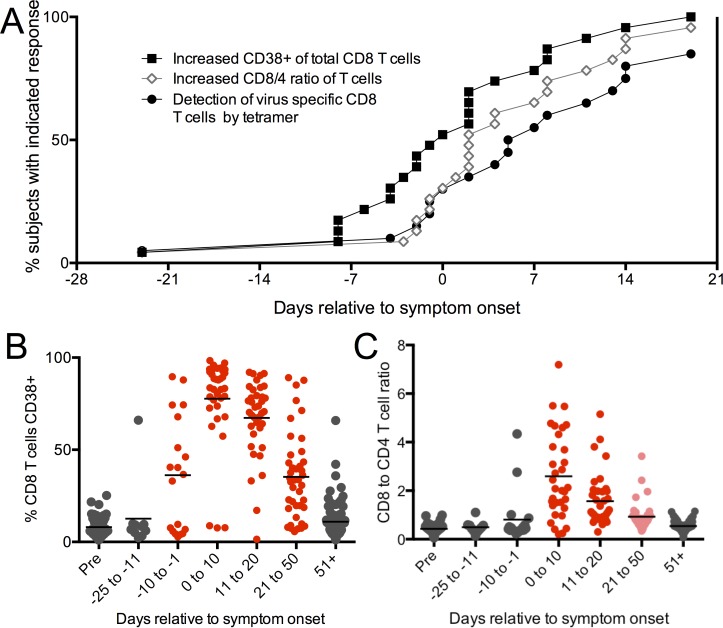
CD8 T cell activation occurred during the incubation period, although not an EBV specific response.(A), Time to first response for three distinct immune parameters is shown: CD38 upregulation on total CD8+ T cells (filled squares), an increased CD8 to CD4 T cell ratio (open diamonds), or the presence of EBV tetramer binding CD8+ T cells above background (0.4%) (filled circles). (B) Frequency of CD8+ T cells expressing CD38 over time. (C) Ratio of CD8+ to CD4+ T cells over time. Statistics were performed using a one-way ANOVA with multiple test comparison. Pink symbols indicate a significant difference (p<0.05) compared to pre-infection. Red symbols indicate a significant difference (p<0.0001) compared to pre-infection. Gray symbols indicate no statistical difference.